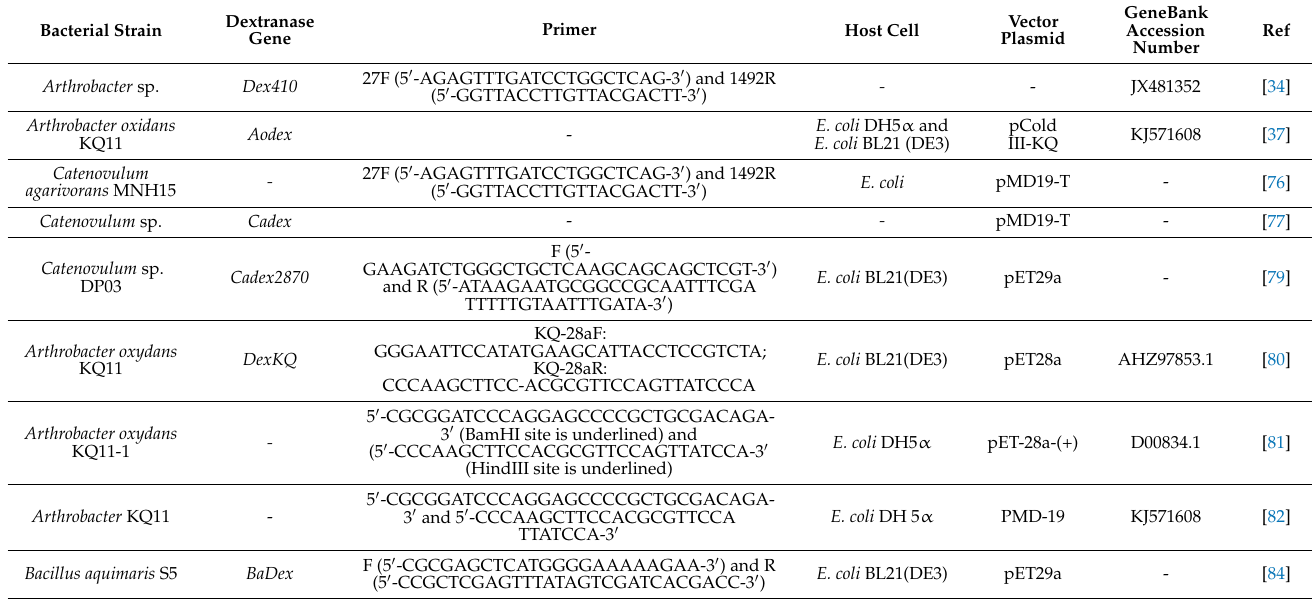
Table 3. Recombinant production of dextranase from marine bacterial